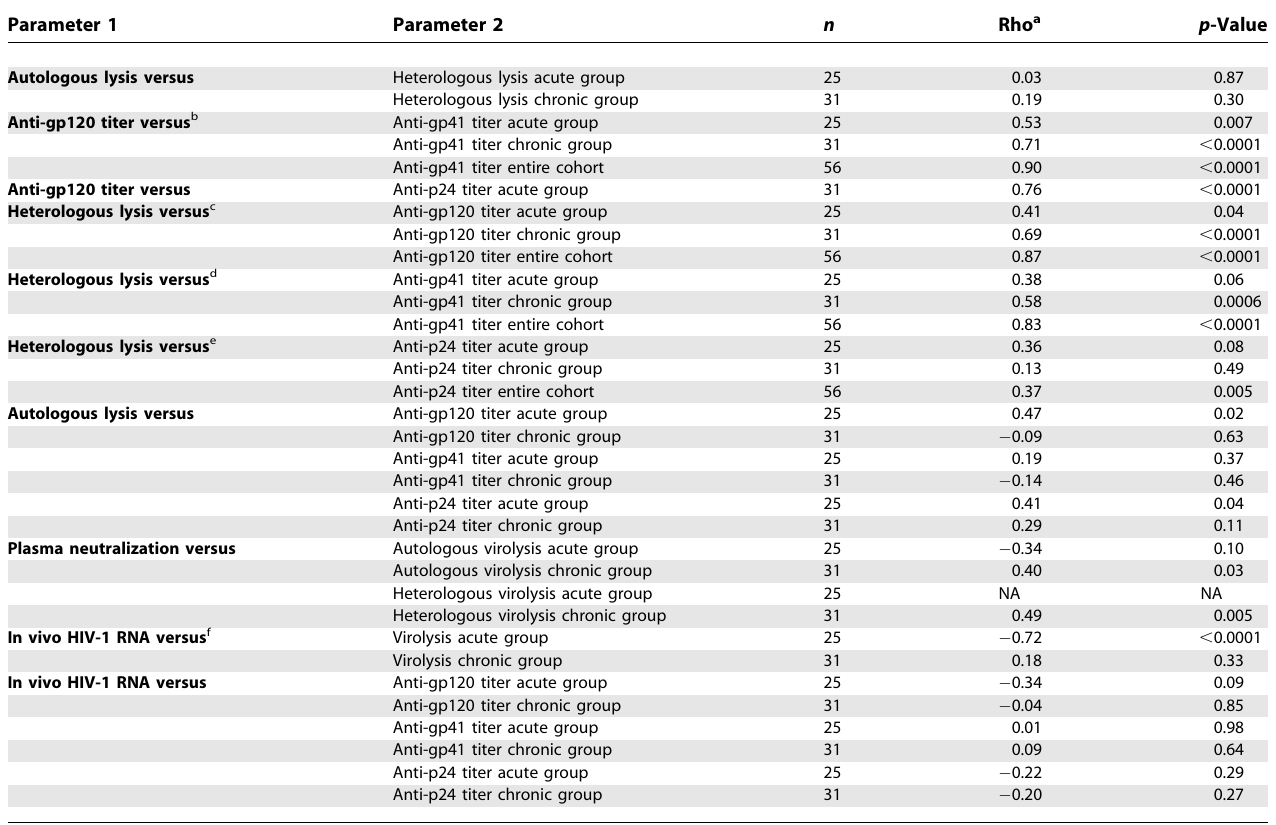
Table 3. Correlation